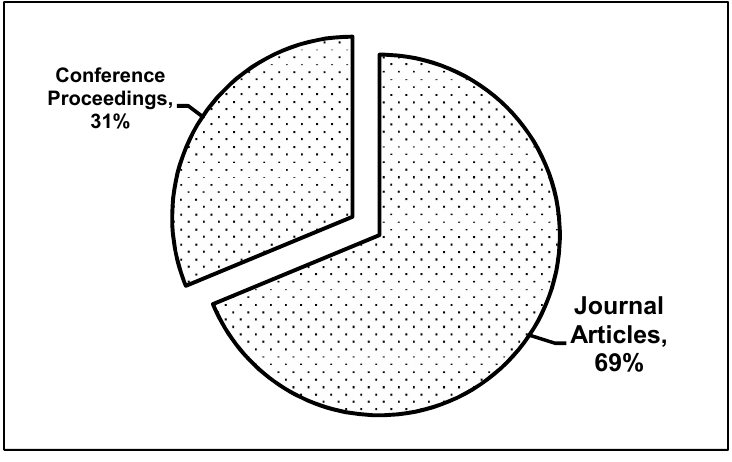
Figure 2. Dataset Distribution.